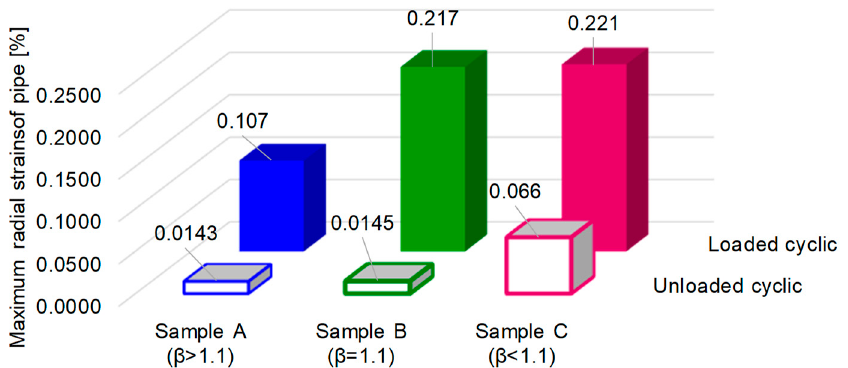
Figure 12. Variation of exterior diameter during test: ( a ) unloading cycles; ( b ) loading cycles. Materials 2019 , 12 , x FOR PEER REVIEW